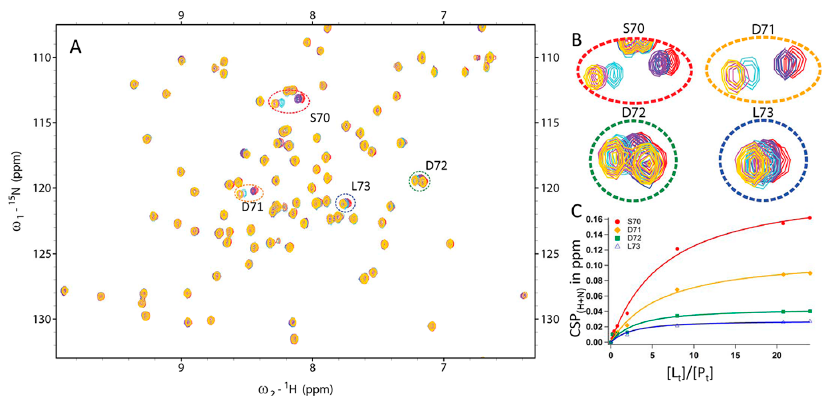
Figure 6. Determination of dissociation constant for ligand-protein complex using 2D NMR. As above these spectra are collected at 750 MHz with a cold probe ( A ) 15 N-HSQC titration of fragment RK207 against BrmGRX. The red contour is apo, blue is 0.2 mM fragment, purple is 0.5 mM, cyan is 2 mM, magenta is 5.2 mM, and yellow is 6 mM As above these spectra are collected at 750 MHz with cold probe; ( B ) An expanded view of perturbed residues that were used to calculate K d ; ( C ) Best fit dissociation constant curves obtained from CSP analysis. Curves for residues 70S, 71D, 72D and 73L are shown. RK207 was found to be ~2.5-fold more reactive towards BrmGRX than for hGRX1, with K d values of 0.98 ± 0.24 and 2.45 ± 0.52 mM respectively. However, no significant selectivity was observed in RK246 for the BrmGRX ortholog on the basis of HSQC-monitored K d (10.63 ± 5.18 mM for BrmGRX and 5.22 ± 1.16 mM for hGRX1) in spite of its larger apparent STD effects. Several binding experiments were performed using 15 N-HSQC-NMR for RK207 analogs against BrmGRX. The goal of the post-hoc